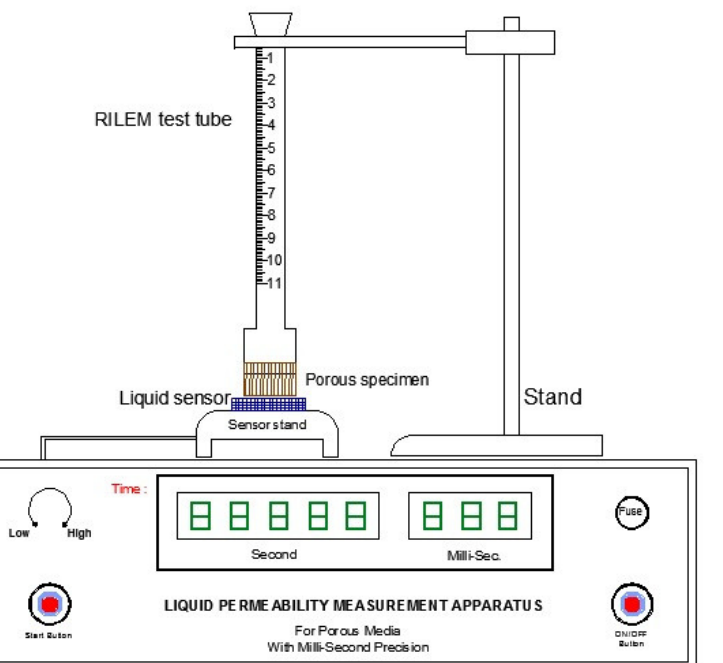
Figure 2. Liquid permeability apparatus designed and built in accordance with the RILEM test method II.4 specifications. The apparatus is equipped with a time-measuring device with milli-second precision [5,14].